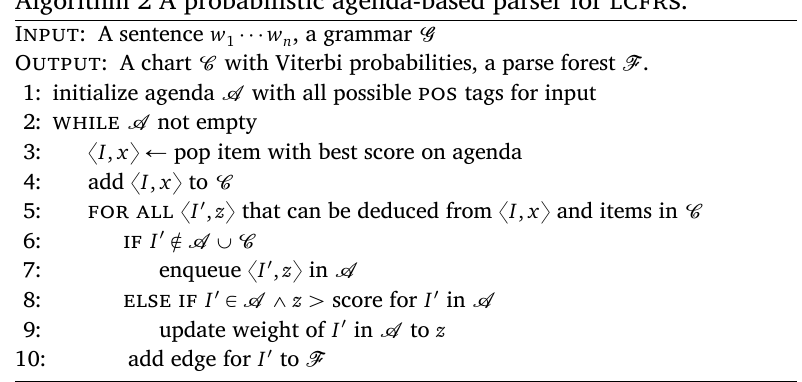
Algorithm 2 A probabilistic agenda-based parser for